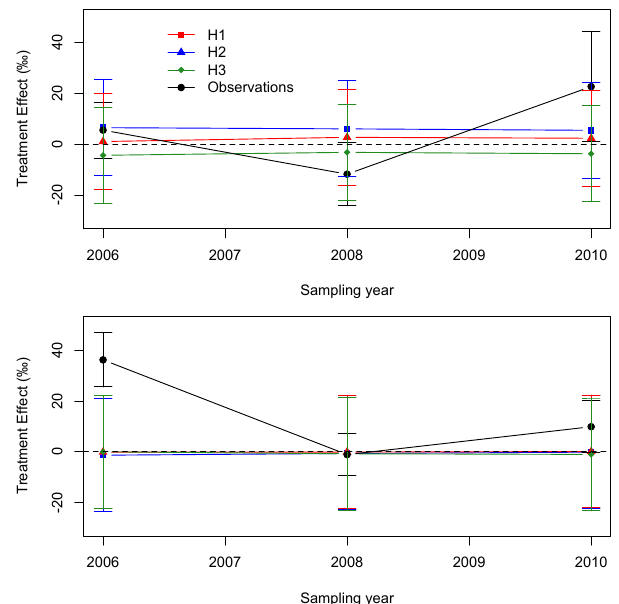
Fig. 8. Observed (in vitro soil incubations) and predicted treatment effects (treatment-control 1 14 C) in the warming treatment. The up- per panel corresponds to the organic layer (fractions 2, 4, and 6 in Fig. 6) and the lower panel to the mineral layer (fractions 1, 3, and 5 in Fig. 6). Error bars in the observations represent the standard de- viation of the sample, and for the model the deviation of predictions with respect to previous